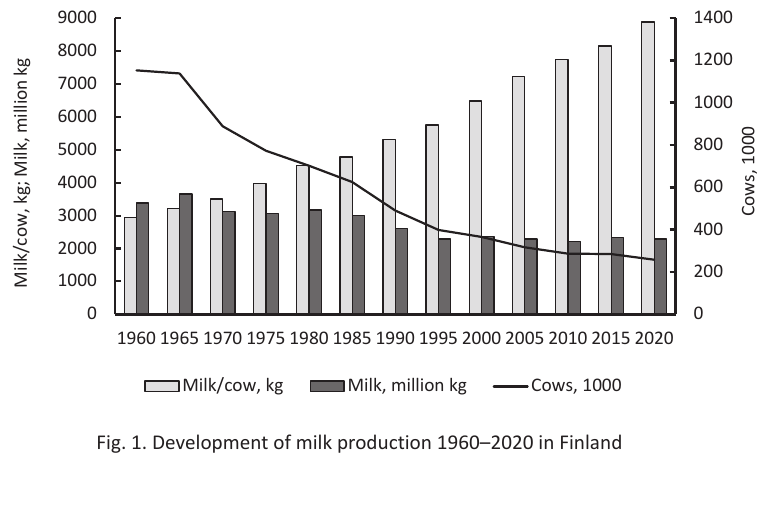
Fig. 1. Development of milk production 1960–2020 in Finland